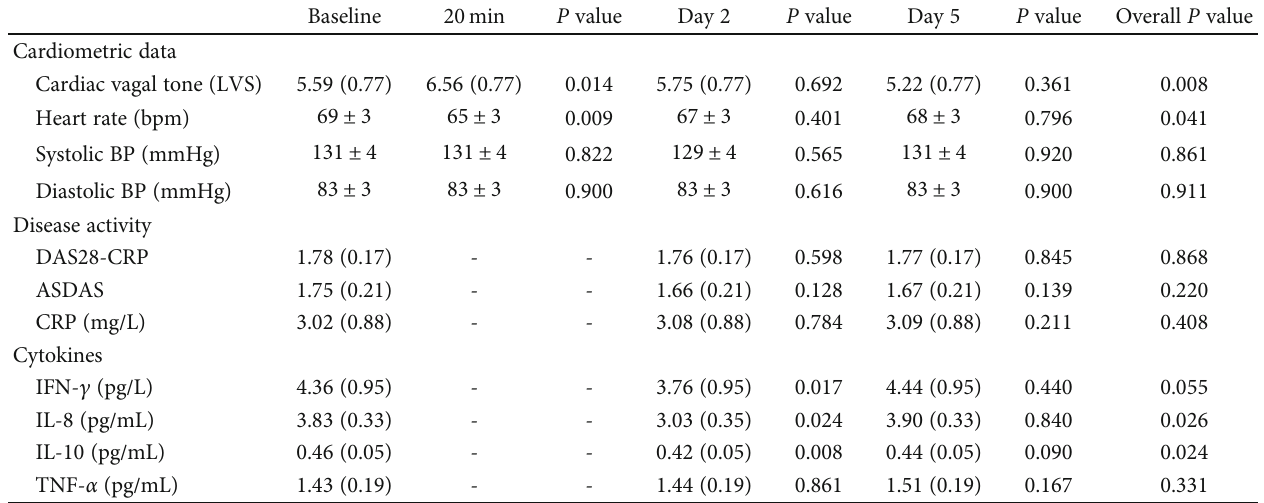
Table 3: Results — ankylosing